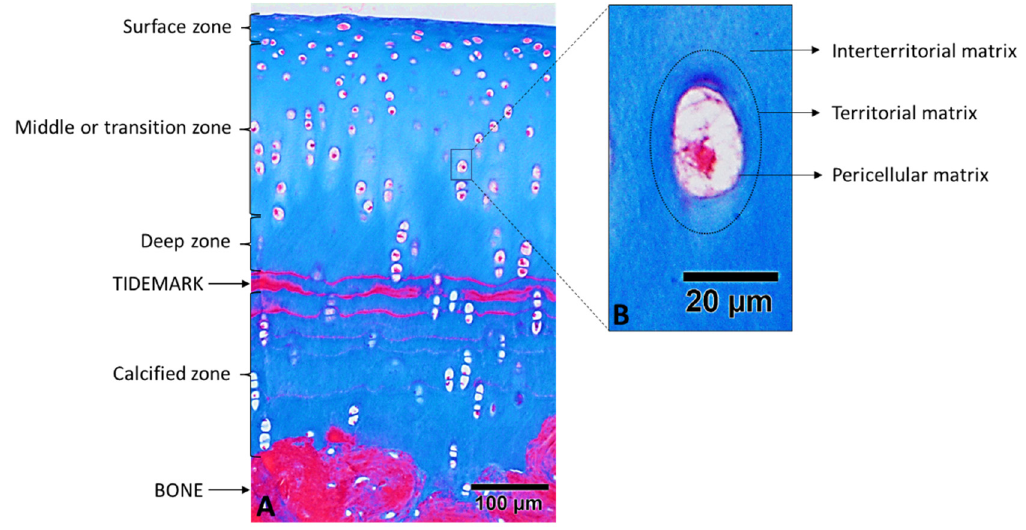
Figure 1. Masson’s trichrome staining of a representative section of healthy hyaline cartilage. ( A ) Cartilage zones. ( B ) Regions of the ECM.